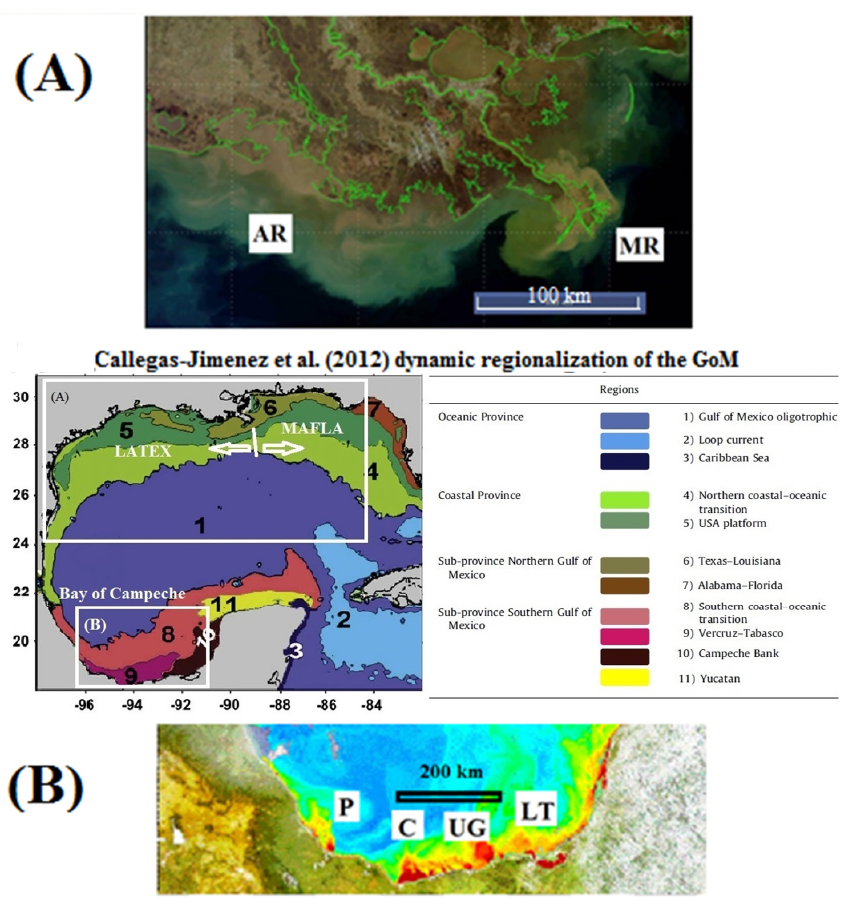
Figure 1. Characteristic surface water types of the GoM as classified by Callejas-Jimenez et al. [3] from MODIS-Aqua satellite images, used by permission. High discharge images of ( A ) the MAR on 2 March 2003, showing Atchafalaya and Mississippi birdsfoot outlets and sediment plume from MODIS-Aqua sensor, and ( B ) Papaloapan (P), Coatzacoalcos (C), Usamacinta-Grijalva (UG) and Laguna de Terminos plumes on 25 October 1997, flood from SeaWifs Chl-a sensor.